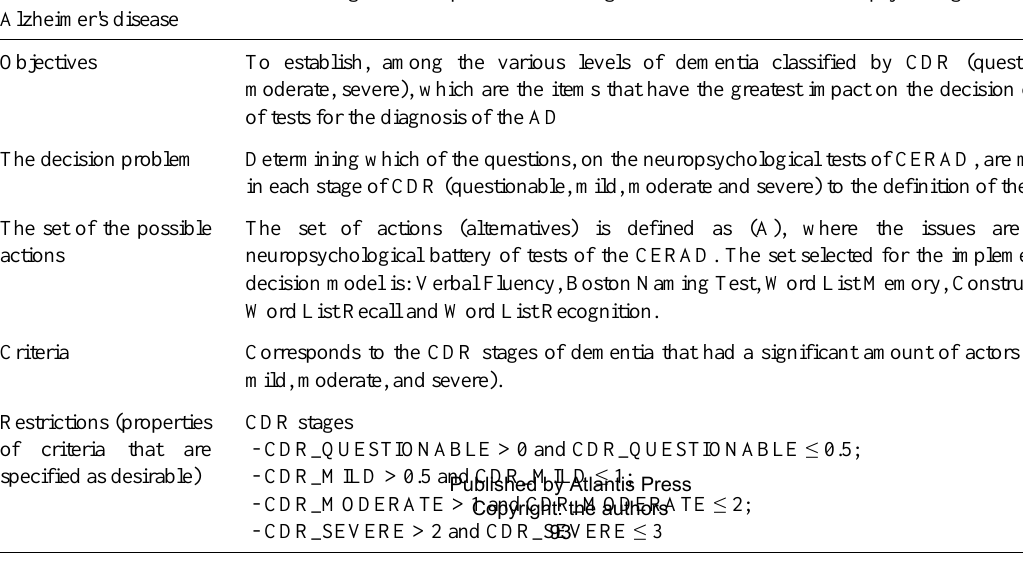
Table 1. Classification of the variables of the decision problem